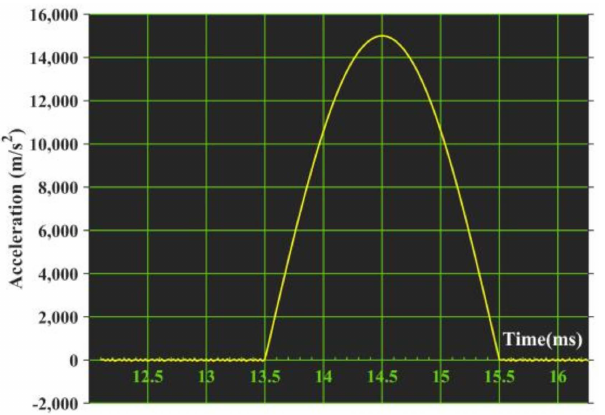
Figure 20. Half–sine